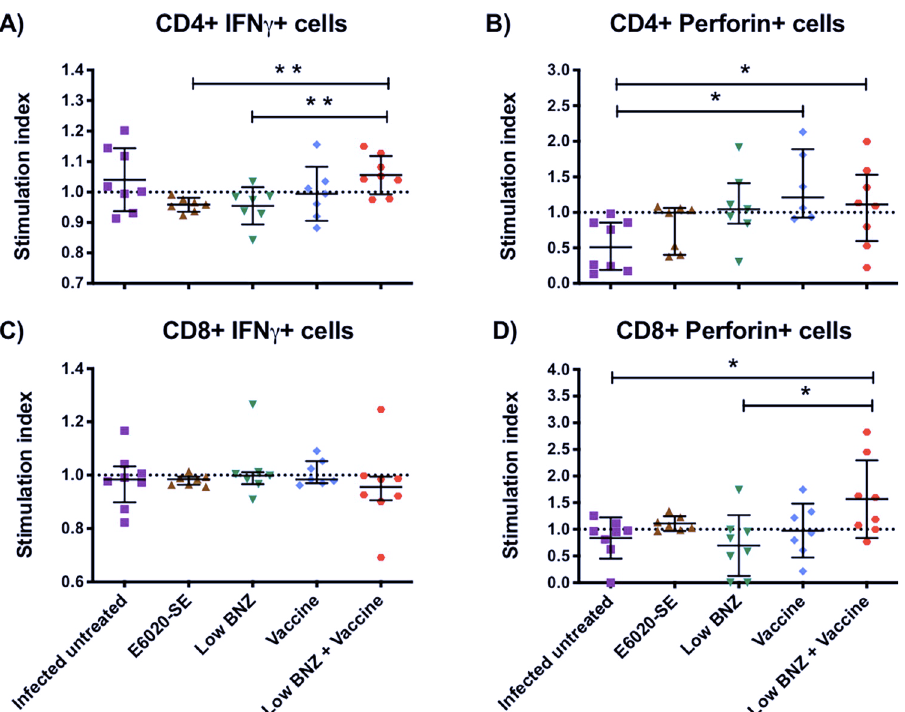
Fig 4. Effect of vaccine-linked chemotherapy on antigen-specific CD4 + and CD8 + T cells functional profile. Mononuclear cells isolated from mice at 200 days p.i were co-cultivated with macrophages stimulated in vitro with TSA-1-C4+Tc24-C4 (25 μ g/mL) for 20 h. Data were analyzed using FlowJo X software. Stimulation index of ( A ) antigen-specific IFN γ -producing CD4 + cells, ( B ) perforin-producing CD4 + cells, ( C ) IFN γ -producing CD8 + cells and ( D ) perforin-producing CD8 + cells are presented. Each point represents an individual mouse, horizontal lines denote means ± SD or median ± interquartile ranges values according to the normality of the data. Data were analyzed using Student´s t-test or Mann-Whitney U-test. Significance is indicated as follows � , P � 0.05; �� , P � 0.01.